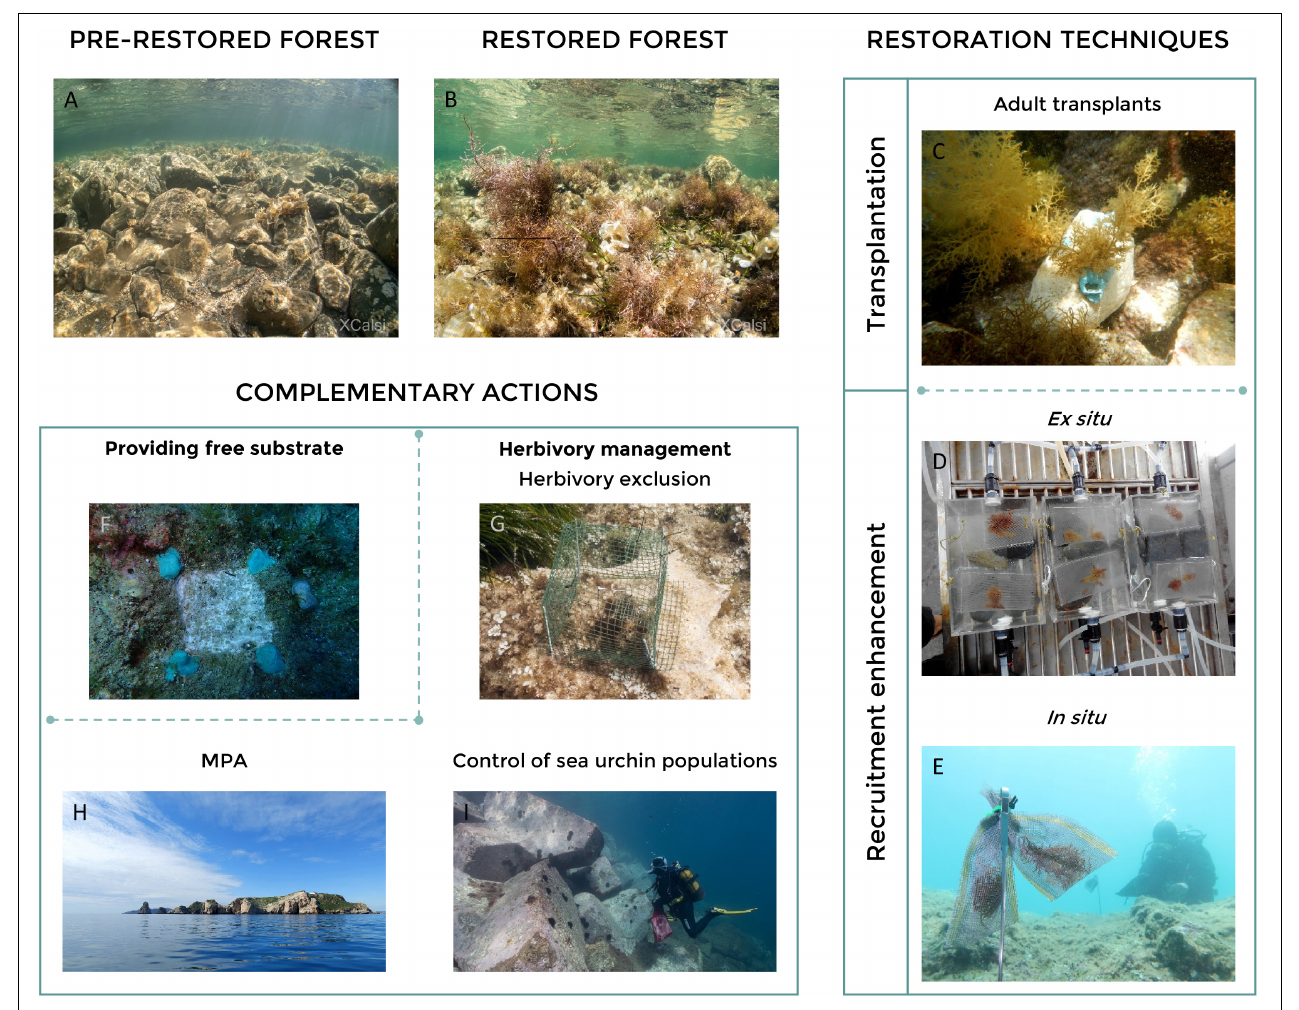
FIGURE 2 | Image of the rocky reef before the restoration action (A) and after restoring the Cystoseira s.l. population (B) . Restoration techniques: Cystoseira s.l. adult transplantation (C) , ex situ approach (D) and in situ recruitment enhancement (E) . Complementary actions: providing free substrate (F) , herbivory exclusion (G) , MPAs (H) and control of sea urchin populations (I) . Photo credits: Xavi Calsina (@XCalsi; A,B,G ), Margalida Monserrat (C) , Jana Verdura (D) , Simonetta Fraschetti (E) , Alba Medrano (F) , Josep Pascual (H) and Jordi Boada (I)